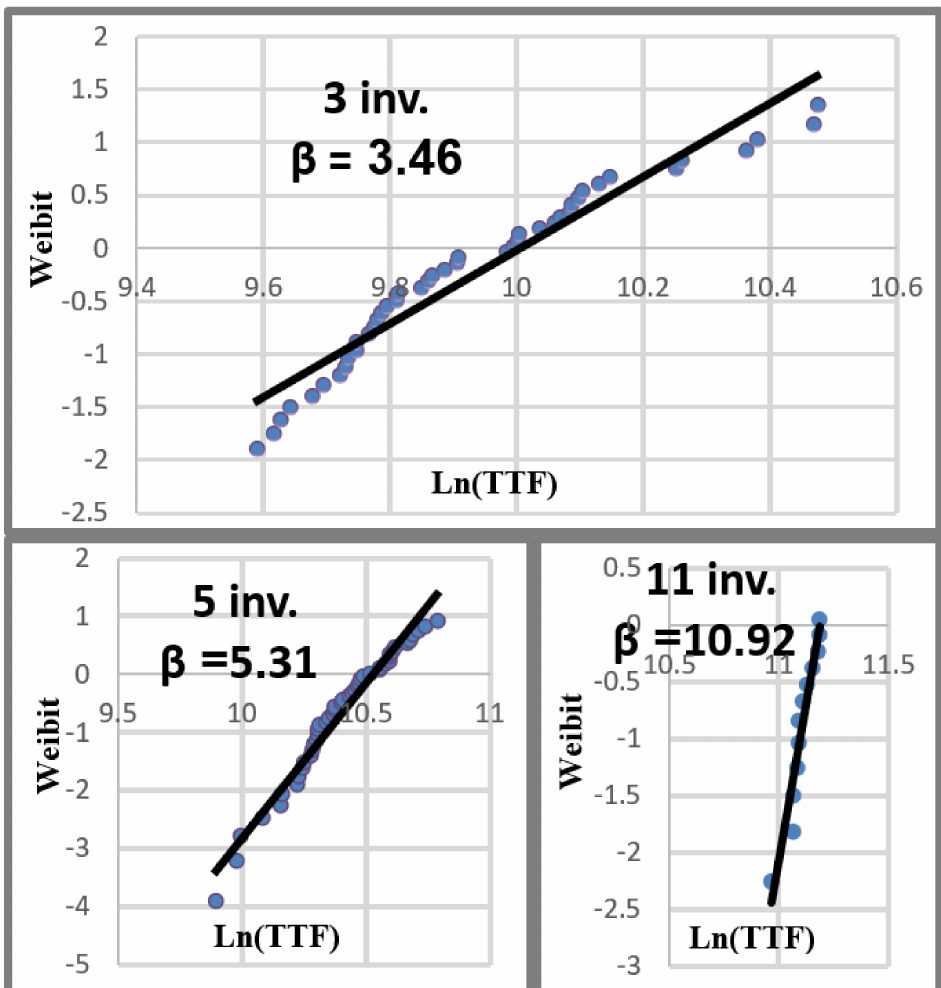
Figure 8. Weibull plots of 3, 5, and 11 inverter ring oscillators. The results demonstrate the direct correlation between number of inverters and Weibull slope β